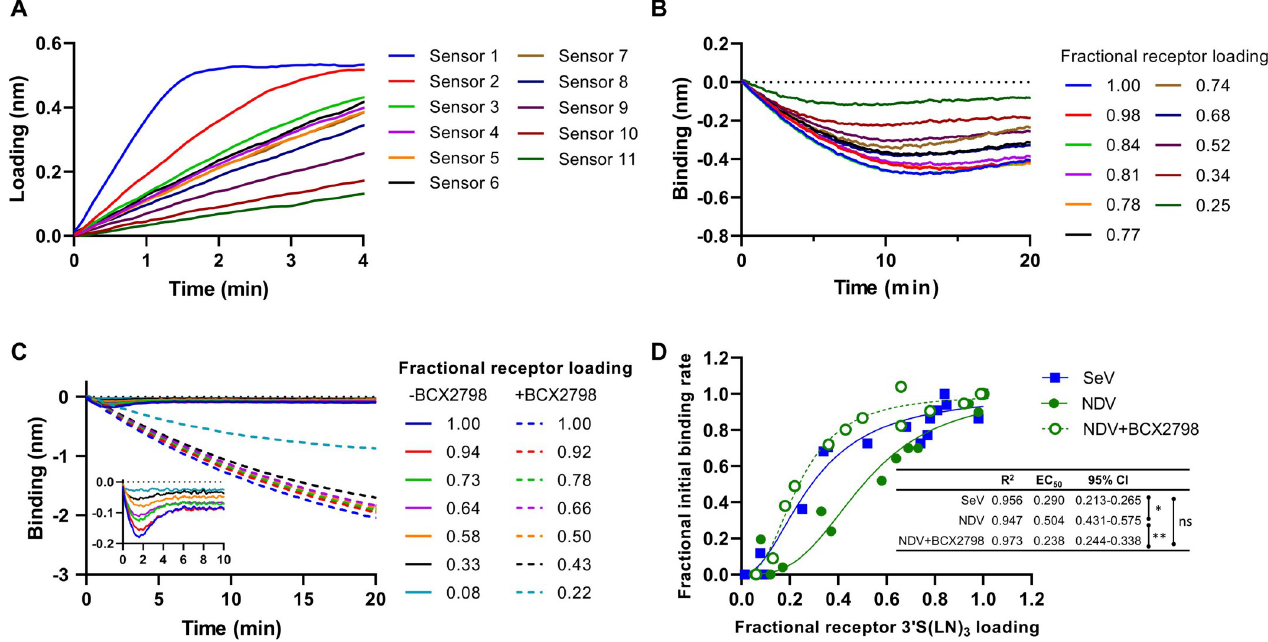
Fig 6. Characterization of NDV and SeV binding kinetics through BLI. (A) Sensors were loaded with different densities of 3’S(LN) 3 receptor by incubation with different concentrations of receptor. Fractional receptor loading levels were obtained by normalizing receptor binding signals to the signal of sensors containing saturating receptor levels (e.g. sensor 1). Subsequently, sensors were incubated with SeV (B) or with NDV in the presence or absence of BCX2798 (C). The initial binding rate, corresponding to the steepness of the tangent at the beginning of the binding curves was determined form graphs B and C and normalized to the maximal, saturating initial binding rate for each condition, resulting in a fractional initial binding rate. (D) The fractional initial binding rates for SeV, NDV and NDV+BCX2798 were plotted against the fractional receptor density for two independent experiments. Using Graphpad prism software, EC 50 values and 95% confidence intervals (CI) were determined by nonlinear regression analysis (sigmoidal 4PL, R 2 values are indicated). Significant differences between EC 50 values (one-way ANOVA with Tukey’s multiple comparisons test; * , p < 0.05; ** , p < 0.01) are